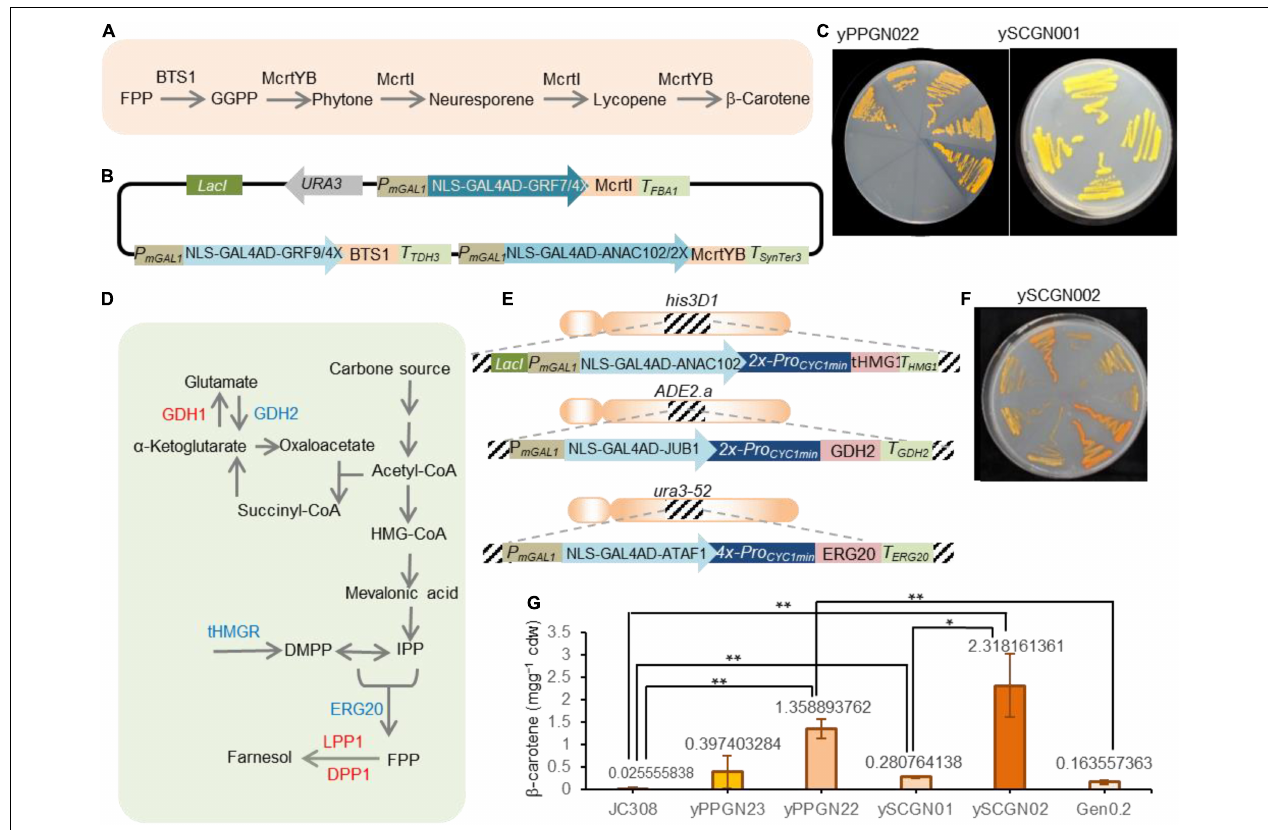
FIGURE 5 | Production of β -carotene in yeast strains. (A) Scheme showing the β -carotene production from FPP precursor. BTS1, geranylgeranyl diphosphate synthase; FPP, farnesyl diphosphate; GGPP, geranylgeranyl diphosphate; McrtYB, optimized phytoene synthase/lycopene cyclase; McrtI, phytoene desaturase. (B) Scheme showing the β -carotene-encoding plasmid. The pCAROTENE plasmid was constructed as described by Naseri et al. (2019). McrtI , McrtYB , and BTS1 genes are under the control of ATF/BSs NLS-GAL4AD-GRF9-4X, NLS-GAL4AD-GRF7-4X, and NLS-GAL4AD-ANAC102-4X. The ATF/BS-McrtI , -McrtYB -, and -BTS1 modules are flanked by the IPTG inducible modified GAL1 promoter. Additionally, the ATF/BS-McrtI module encodes the LacI repressor. Selection on SC-URA media allows screening for successful plasmid integration. To simplify the figure, the CYC1 terminator located downstream of ATF is not shown. AD, activation domain; ATF, artificial transcription factor; BS plantTF , binding site of the plant TF; DBD, DNA binding domain; IPTG, isopropyl- β -D-thiogalactopyranoside; NLS, nucleus localization signal; Pro minCYC 1 , CYC1 minimal promoter; Ter, terminator. (C) Representative plate of the constructed β -carotene producing strains. The pCAROTENE plasmid was transformed to P. pastoris and S. cerevisiae to generate the yPPGN022 and ySCGN01, respectively. Upon adding IPTG, plant-derived ATFs were expressed and β -carotene was produced. Colors of carotenoid-producing yeast strains in YPDA media for the yPPGN022 and ySCGN01 strains. (D) Scheme illustration of FPP precursor production in yeast. To redirect yeast metabolisms toward the FPP production, GDH2, ERG20, and tHMG1 overexpression (blue), deleted or inactive DPP1 , LPP1 and GDH1 (red) are needed. ERG20, FPP synthase; DPP1 and LPP1, lipid phosphate phosphatases; tHMG1, truncated HMG-CoA reductase, GDH1, NADP + -glutamate dehydrogenase; GDH2, NAD + -dependent glutamate dehydrogenase; HMG-CoA, 3-hydroxy-3methylglutaryl-CoA; IPP, isopentenyl diphosphate; DMAPP: dimethylallyl diphosphate. (E) Scheme representing overexpressing donors for the enhanced production of FPP. ATFs NLS-GAL4AD-ANAC102-2X , NLS- GAL4AD-JUB1-2X , and NLS-GAL4AD-ATAF1-4X are fused to tHMG1-T HMG 1 , GDH2-T GDH 2 , and ERG20-T ERG 20 . The tHMG1 , GDH2 , and ERG20 donors are flanked by 50-bp homology arms to integrate into the his3D1 , ADE2.a , and ura3-52 loci, respectively. In each donor, a modified GAL1 promoter is located upstream of the plant-derived ATF. Additionally, the tHMG1 donor encodes LacI. The BS of ATFs is placed upstream of the CYC1 minimal promoter to drive gene expression. NLS, nuclear localization signal; JUB1, plant JUNGBRUNNEN1 transcription factor; GAL4AD, yeast GAL4 activation domain; ANAC102, NAC domain containing protein 102; ATAF1, Arabidopsis thaliana Activating Factor 1; “2X”, and “4X” indicate two, or four copies of the plant TF binding site, respectively. (F) Colors of the carotenoid-producing ySCGN02 S. cerevisiae strain (optimized for FPP production) in YPDA media. (G) SFC analysis of the carotenoid content of yeast strains. Values represent the mean ± SD of three independent colonies after 3 days of cultivation. P. pastoris strains yPPGN023 containing pCAROTENE-PGAP plasmid and J308 were used as a positive and negative controls, while Gen 0.2 was used as a negative S. cerevisiae control. Asterisks indicate a statistically significant difference (Student’s t- test; ∗ p < 0.05; ∗∗ p < 0.01). Cdw, cell dry weight. Full data are shown in Supplementary Data 4